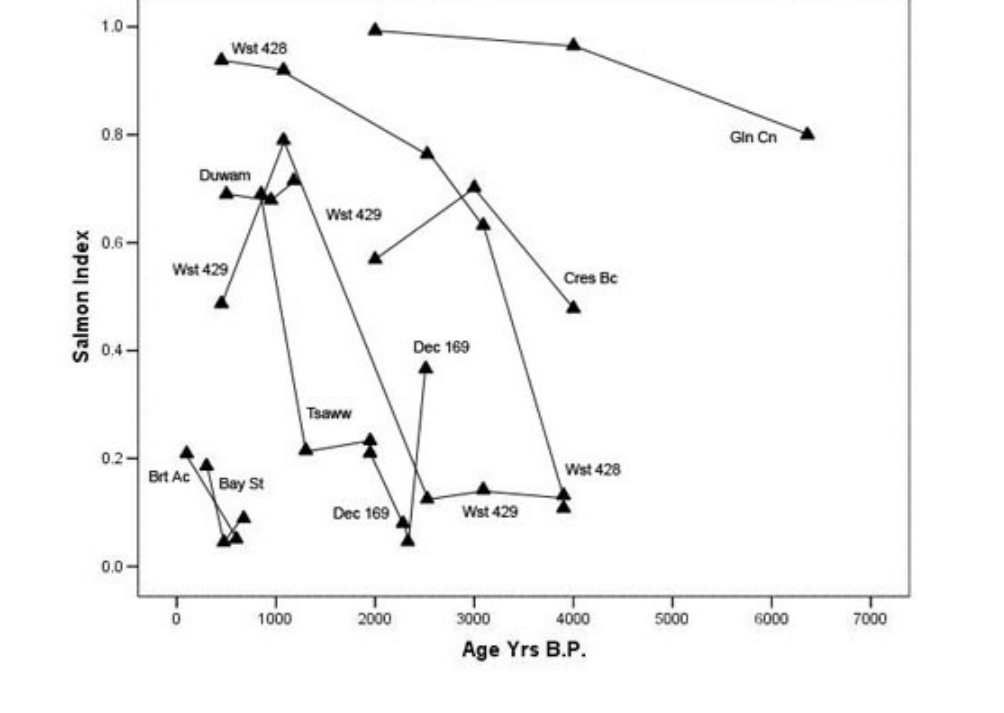
Fig. 3. Changing salmon ratios within sites with multiple dated components, South–central Northwest Coast sites(salmon index: frequency of salmon bones/number of all fish bones). Site abbreviation key: Gln Cn—Glenrose Cannery; Wst 428—Westpoint KI 428; Wst 429—Westpoint KI 429; Cres Bc— Crescent Beach; Dec 169—Decatur Island; Tsaww—Tsawwassen; Duwam—Duwamish; Bay St—Bay Street; Brt Ac—Burton Acres. See Butler and Campbell (2004) for more site